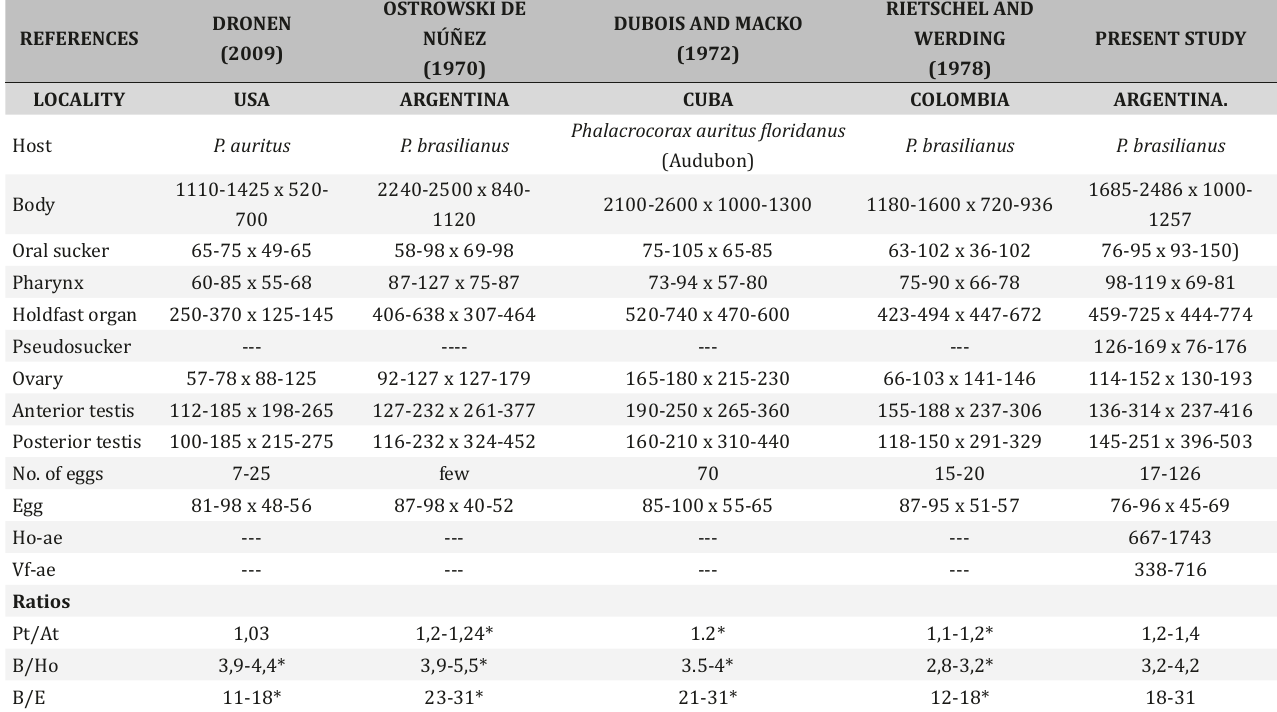
Comparative measurements (in micrometers) of *Calculated from original